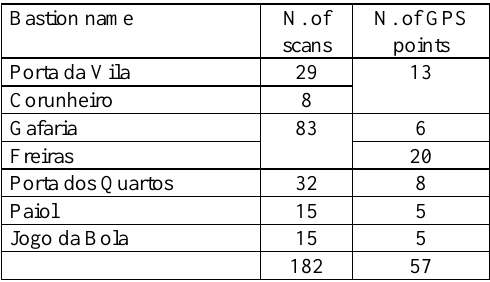
Table 1. Number of scans and GPS points collected